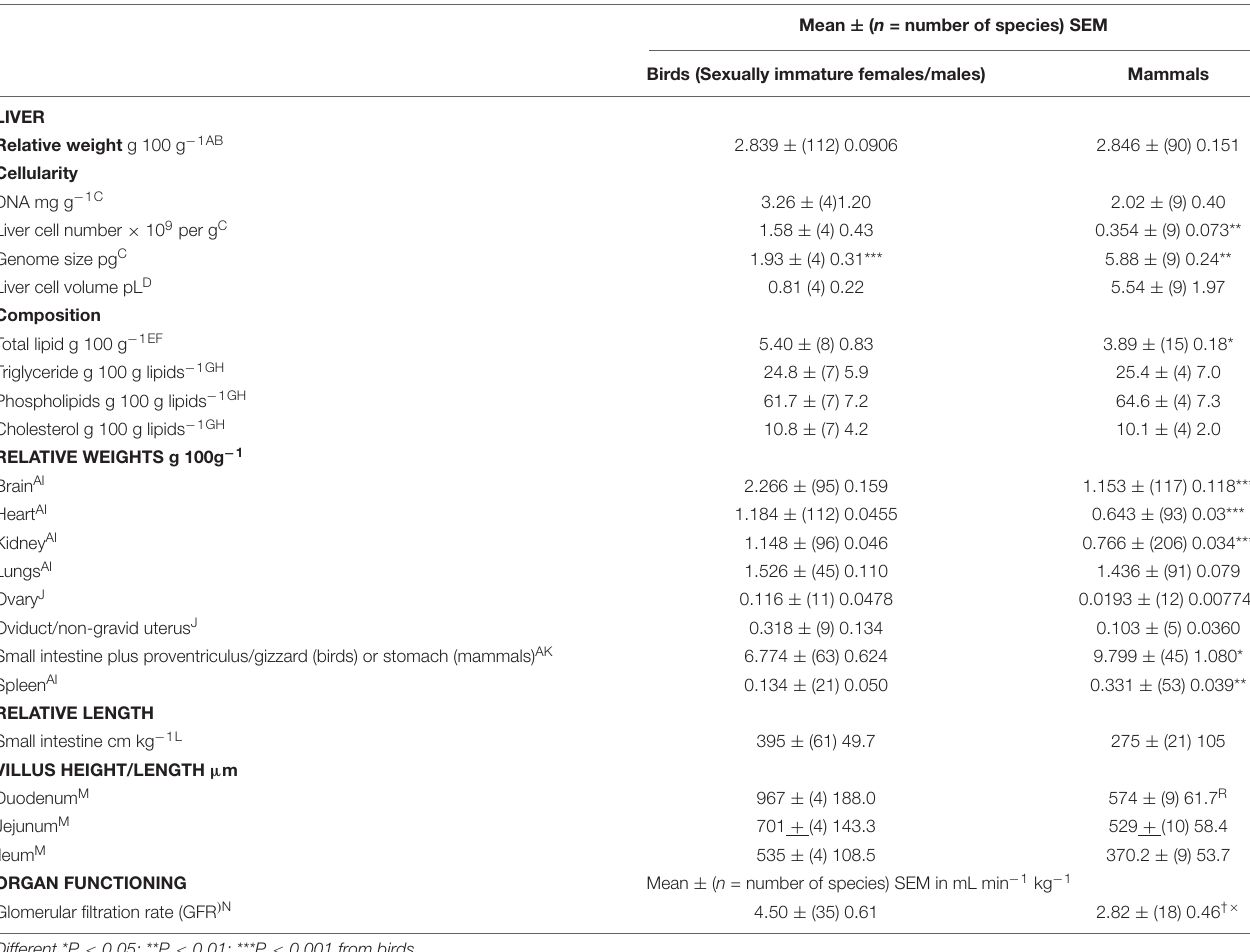
TABLE 3 | Comparison of the relative weights of major organs (as a percentage of body weight) between avian and mammalian